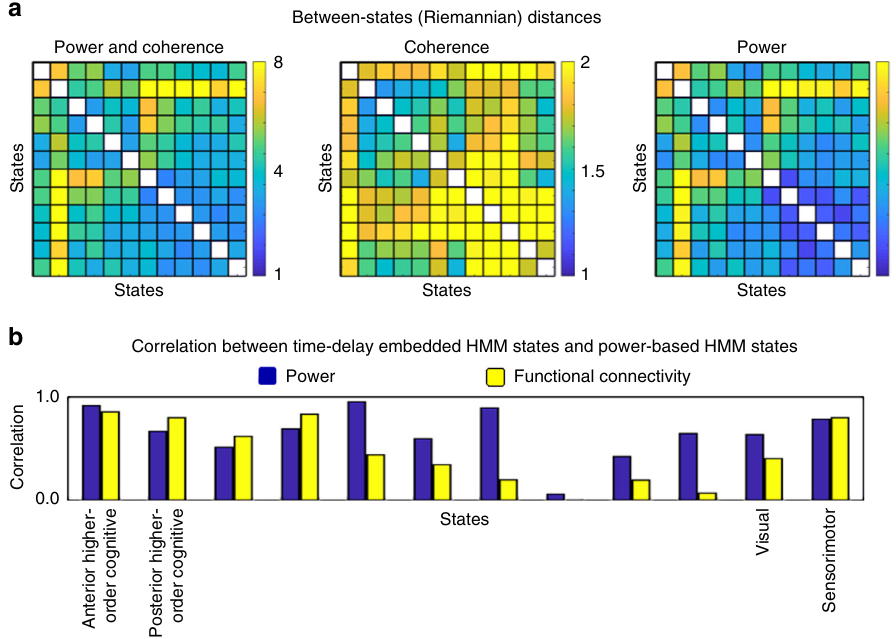
Fig. 7 Oscillatory power contributes more than phase-coupling to state switching. a Riemannian distances between states when we use power and coherence, only coherence and only power. b Correlation between the TDE-HMM and power-based HMM states run on the same